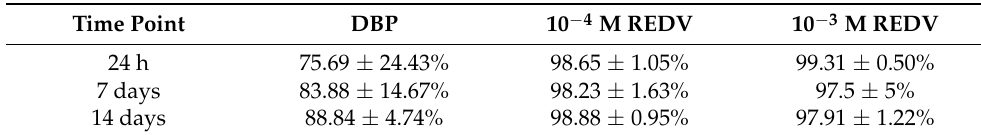
Table 2. HUVECs viability at 1, 7, and 14 days after seeding on DBP control and REDV- functionalized